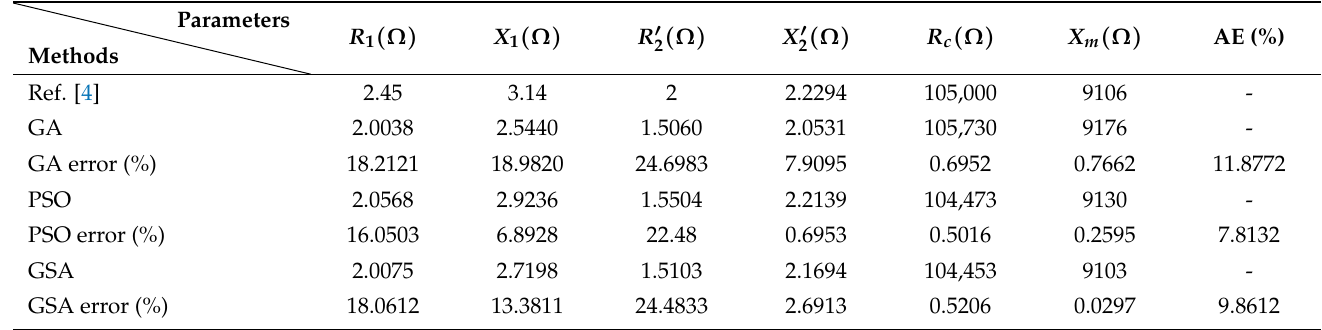
Table 5. Parameters obtained with the optimization methods for the single-phase transformer 15 kVA, 2400–240 V at 50 Hz.